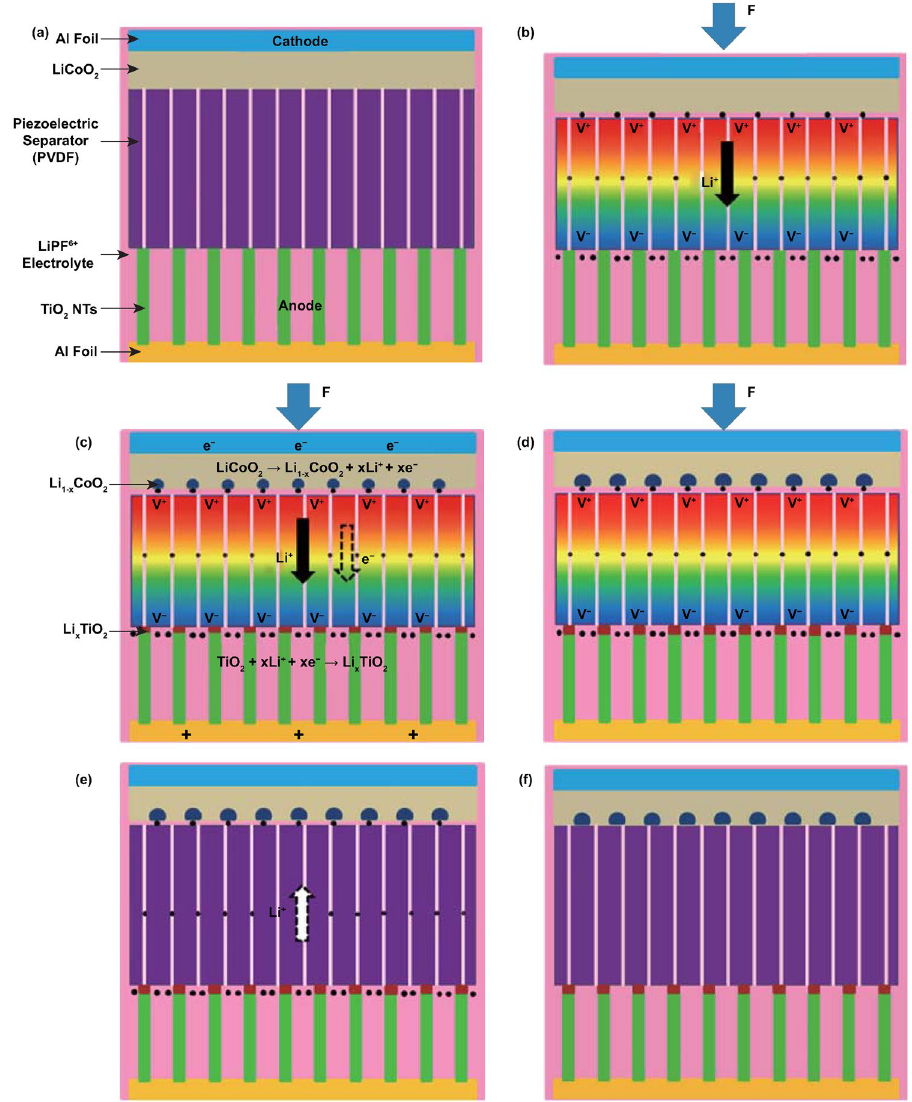
Fig. 4 a Schematic of the self‑charging power cell in discharged state. b Under compressed stress, piezoelectric PVDF film can create a poten‑ tial. c Under the piezoelectric field, Li ions are driven to migrate from the cathode toward the anode, which leads to the corresponding charg‑ ing reactions at the electrodes. d Chemical equilibrium is rebuilt in the self‑charging power cell. e When the compressive stress is released, the piezoelectric field across the piezo‑separator disappears; in the meanwhile, the Li ions diffuse to the cathode side. f New chemical equilibrium is reached, and one typical cycle of self‑charging reaction is accomplished. Reproduced with permission [44]. Copyright 2012, American Chemi‑ cal